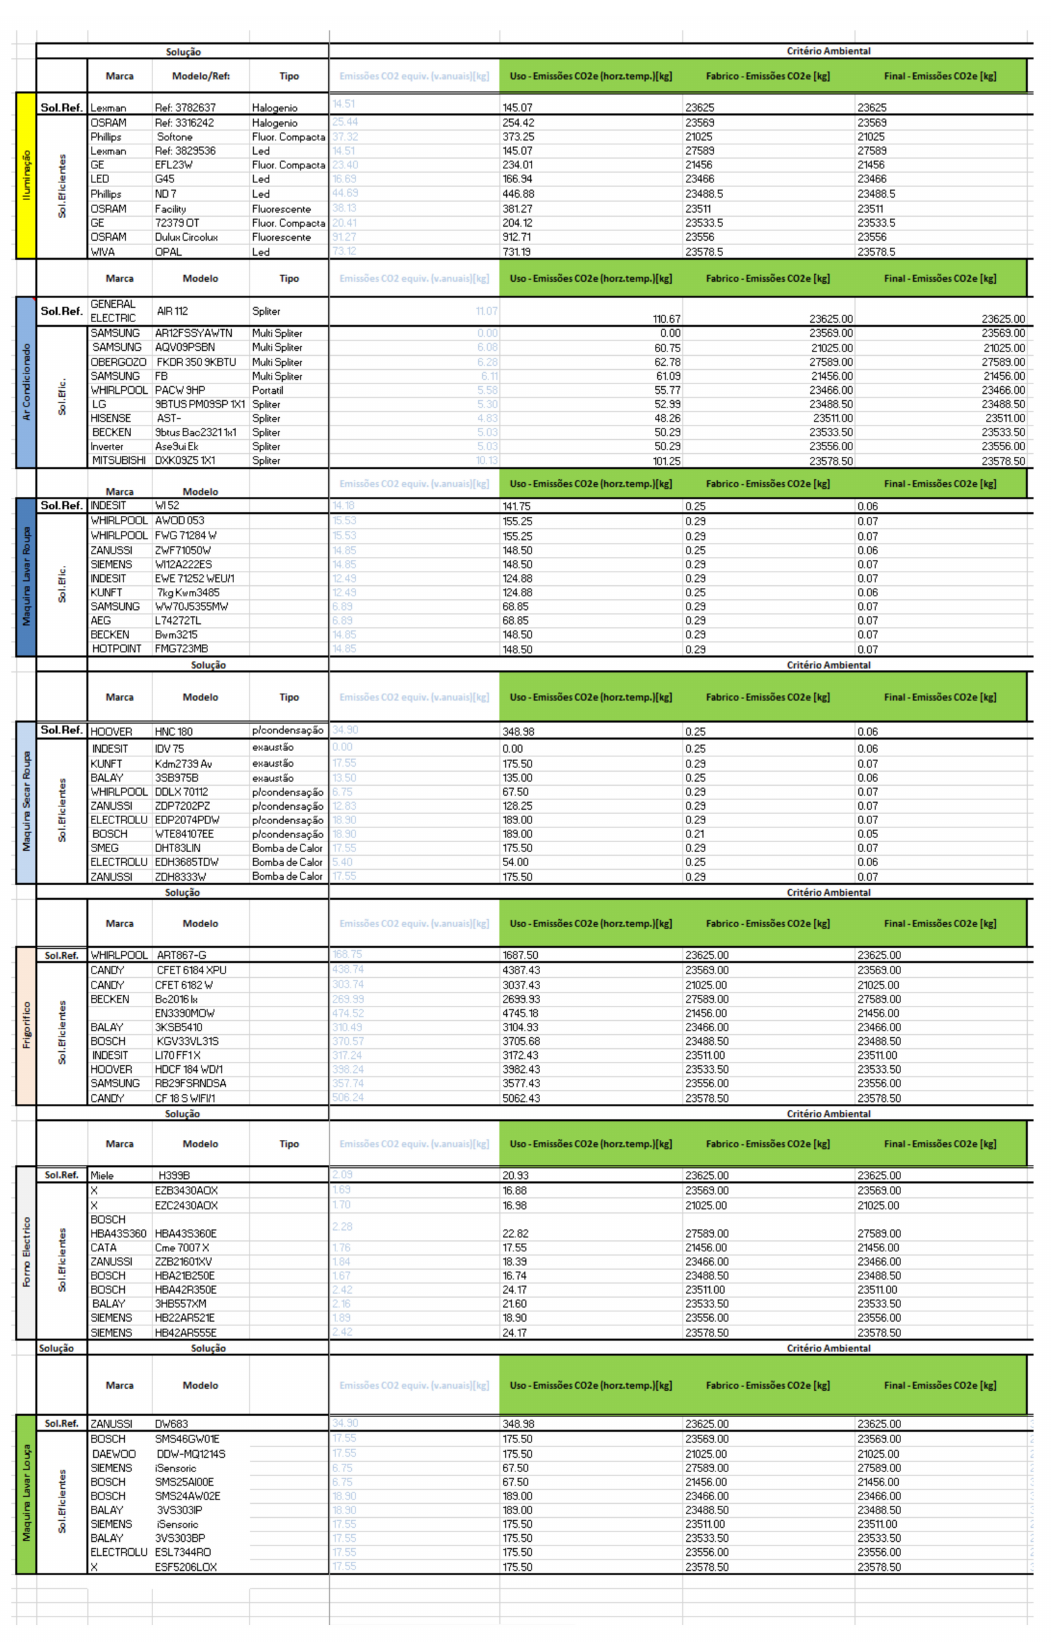
Figure A1. Definition of the attribute table associated with the options available in the market, considered in this